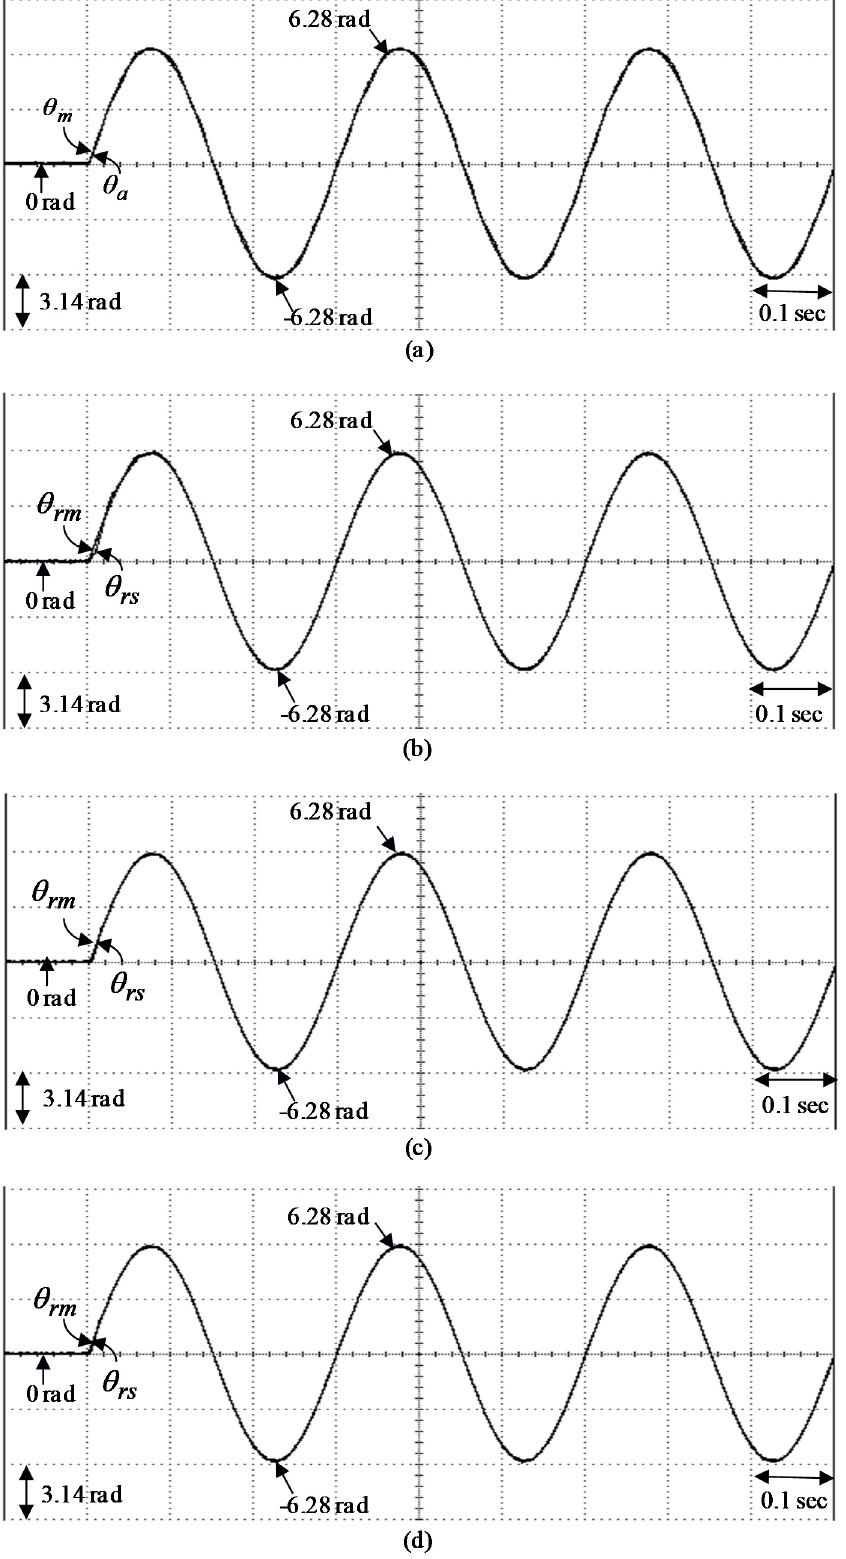
Figure 14. Experimental results of the rotor position response in Case R4 ( a ) by utilizing control system W1, ( b ) W2, ( c ) W3, and ( d ) W4.